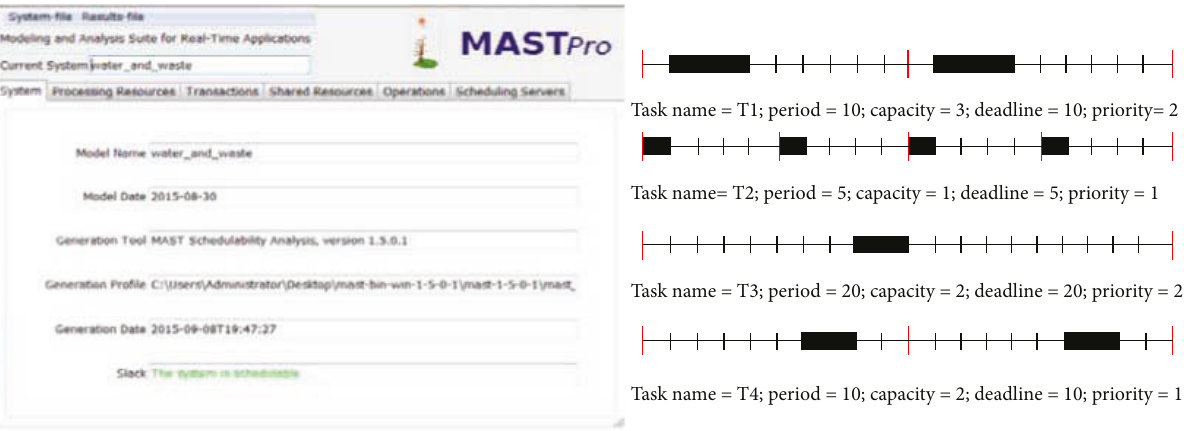
Figure 24: The analysis result of MAST for WAW